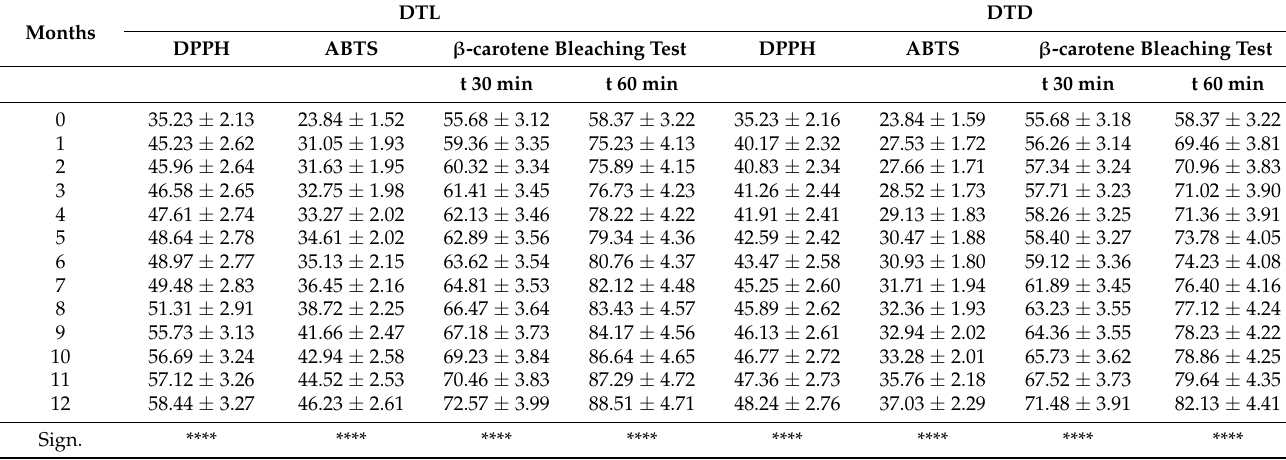
Sign. Data are expressed as the mean ± standard deviation (SD) ( n = 3). Differences within and between groups were evaluated by one-way ANOVA followed by a multicomparison Dunnett’s test ( α = 0.05): **** p < 0.0001 compared with the positive controls (Ascorbic acid for DPPH and ABTS test with IC 50 values of 5.0 ± 0.8 and 1.70 ± 0.06, respectively, and propyl gallate for β -carotene bleaching test with IC 50 values of 0.09 ± 0.00 and 0.09 ± 0.01 at 30 min and 60 min incubation,